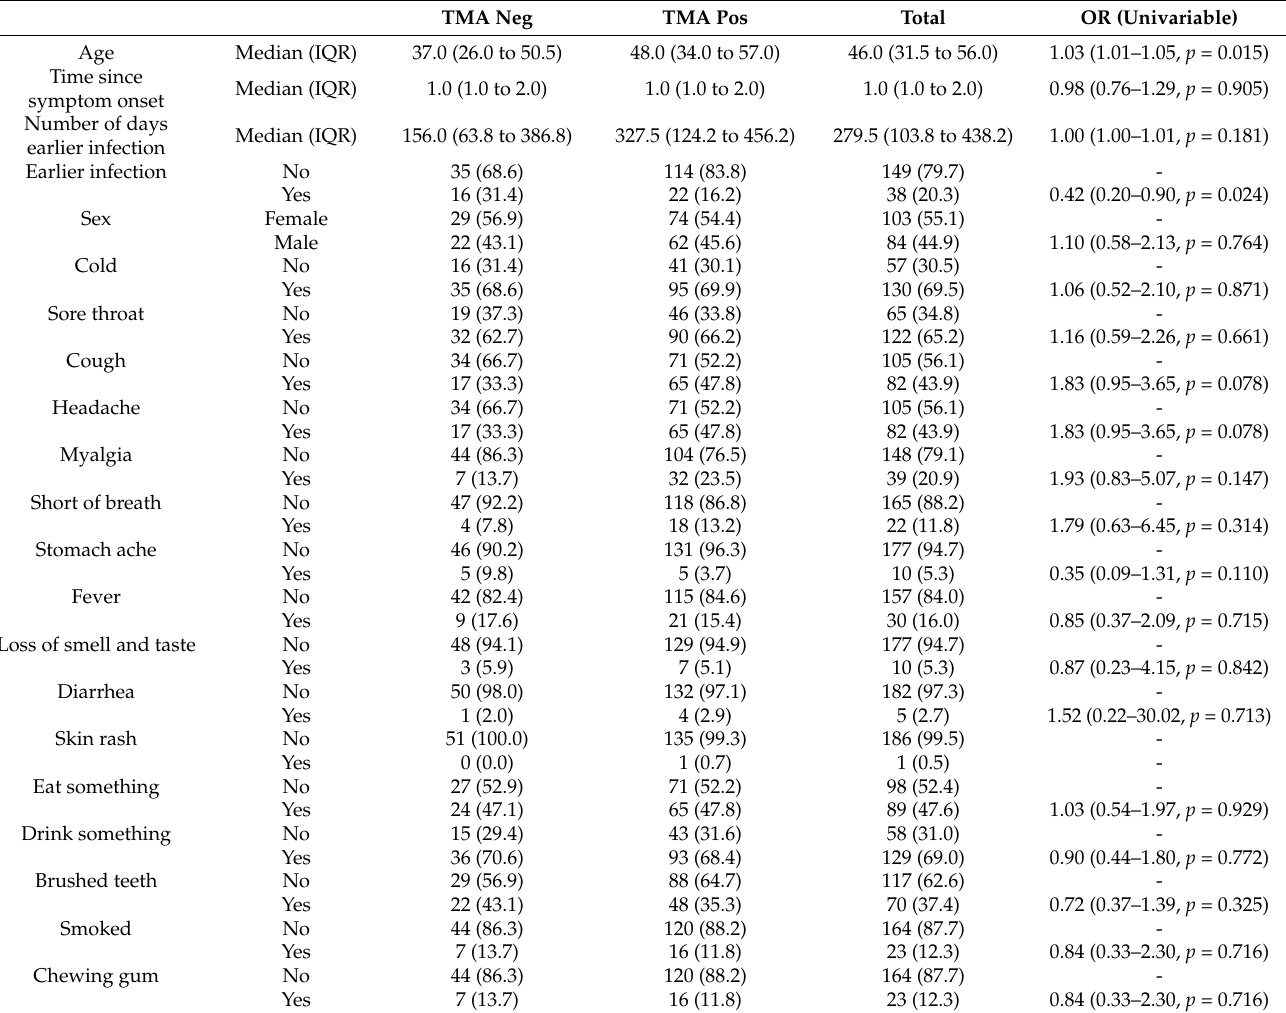
Table 2. Comparison of characteristics between TMA positive and negative